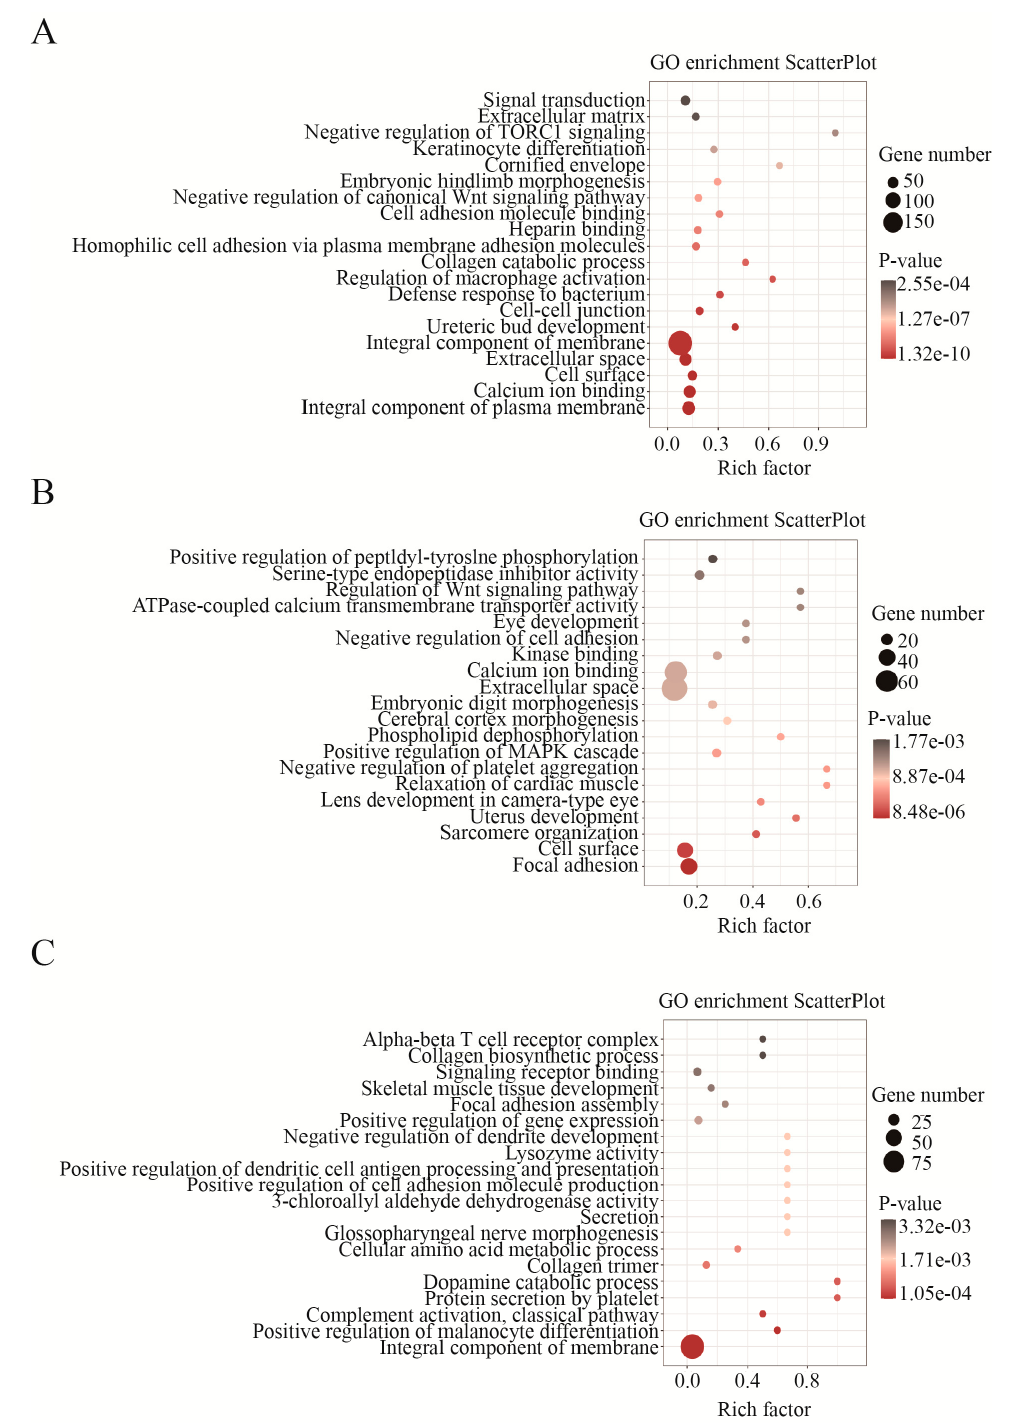
Figure 3. GO analysis of DEGs in HN10 and JDm10 induced the bursa of Fabricius. ( A ) Bubble charts showed GO enrichment (biological process) in the mutual DEGs of the bursa of Fabricius both induced by HN10 and JDm10. ( B ) Bubble charts showed GO enrichment (biological process) in the HN10-specific DEGs of the bursa of Fabricius. ( C ) Bubble charts showed GO enrichment (biological process) in the JDm10 specific DEGs of the bursa of Fabricius.